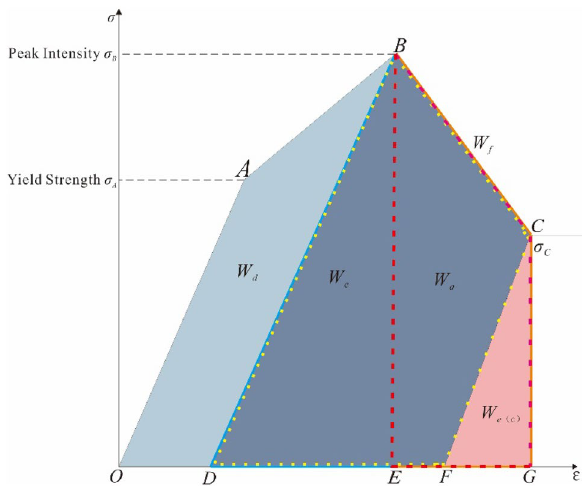
Figure 1. Energy evolution diagram of the whole process of rock